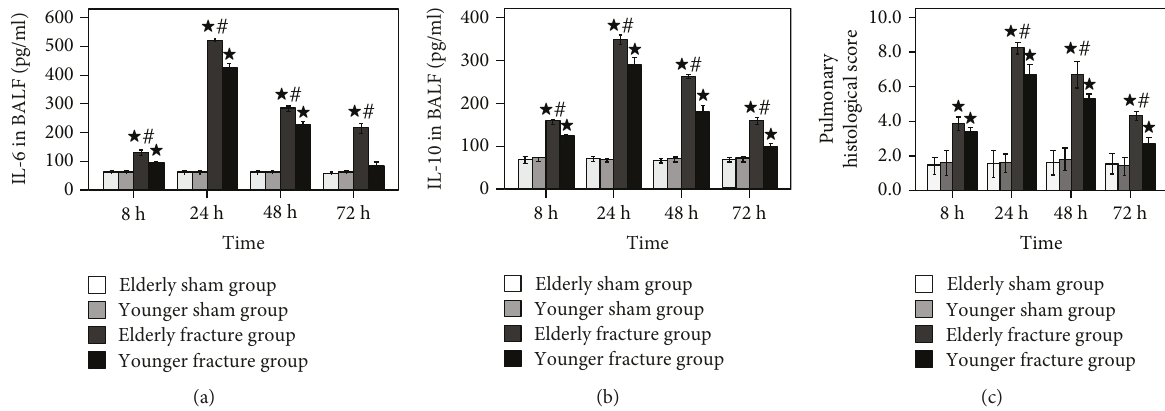
Figure 3: Time course of pulmonary histological score (c) as well as IL-6 (a) and IL-10 (b) concentrations in BALF. Results are expressed as mean ± standard error. Filled star: P < 0 05 for the elderly fracture group versus the elderly sham group and the younger fracture group versus the younger sham group. Pound sign: P < 0 05 for the elderly fracture group versus the younger fracture group. Table 1: The results of pulmonary histological score.